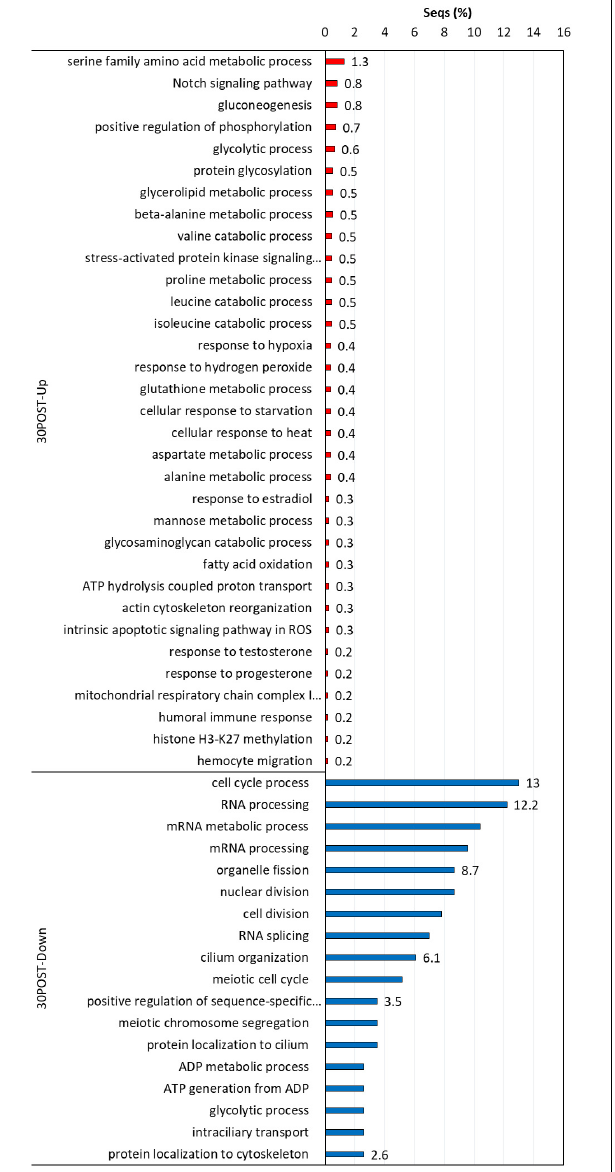
FIGURE 7 | Enriched GO terms of biological processes (Fisher exact test, FDR < 0.05) in 30POST treatment vs. the control treatment (24PRE). Up (red) and down-regulated (blue) transcripts are